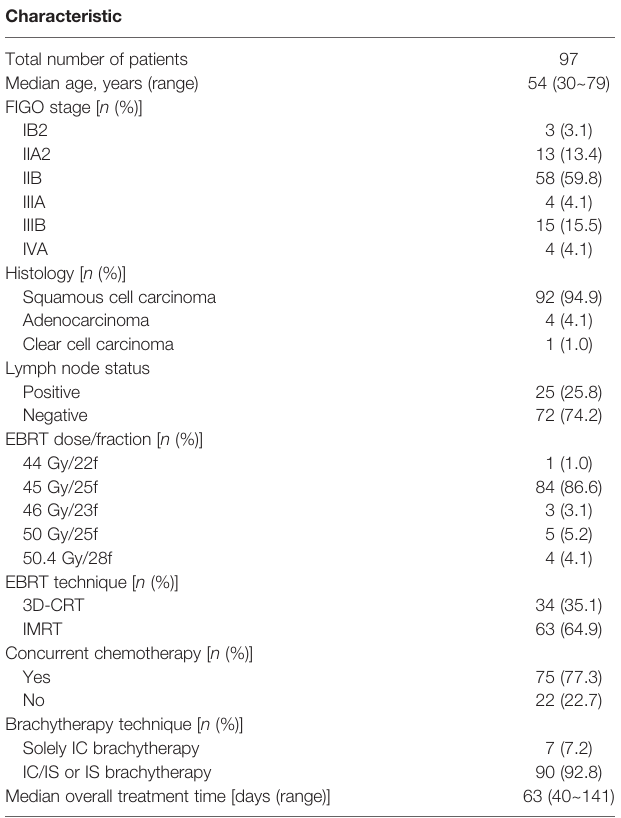
TABLE 1 | Patients and treatment characteristics.